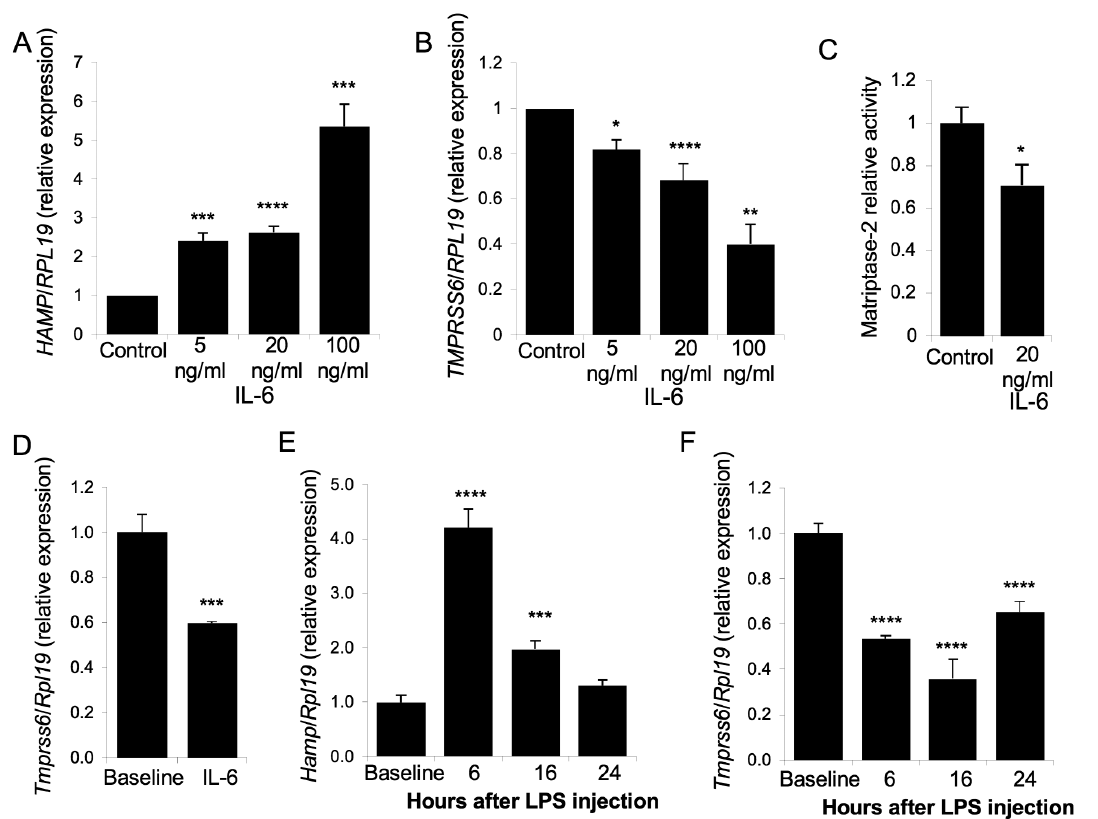
Figure 1. Tmprss6 expression is down-regulated by inflammation. (A–B) Hep3B cells were treated with IL-6 for 16 hours and were analyzed for HAMP and TMPRSS6 relative to RPL19 mRNA expression. For each experiment, raw data were normalized to the value of the non-treated group. Values shown are means of normalized expression values for 4–7experiments + / 2 SEM. Means in treated groups were compared to 1 by one sample student t tests. (C) 15 m g of protein from conditioned media of Hep3B cells treated with IL-6 (20 ng/mL) for 16 hours were used to measure the matriptase-2 activity. Activities were measured in duplicate in 4 independent experiments. Values shown are mean of activities divided by a calibrator quantity (the mean value of activity for the control group) + / 2 SEM. Mean in control and treated groups were compared by student t tests. (D) Mice received 4 intraperitoneal injections of recombinant mouse IL-6 and were sacrificed 3 hours after the last injection. Tmprss6 relative to Rpl19 mRNA expression was analyzed by quantitative real-time RT- PCR. Values shown are means of expression values divided by a calibrator quantity (the mean value of expression for the baseline group) + / 2 SEM. Means in baseline and treated groups were compared by student t tests. (E–F) Mice received one injection of LPS (n=5 per group) and were sacrificed 6, 16 and 24 hours after injection. Hamp and Tmprss6 relative to Rpl19 mRNA expression were analyzed by quantitative real-time RT- PCR. Values shown are means of expression values divided by a calibrator quantity (the mean value of expression for the baseline group) + / 2 SEM. Means in baseline and treated groups were compared by student t tests. p values p , 0.05 were considered statistically significant. Significances are: *p , 0.05; **p , 0.01; ***p , 0.005; ****p , 0.001.